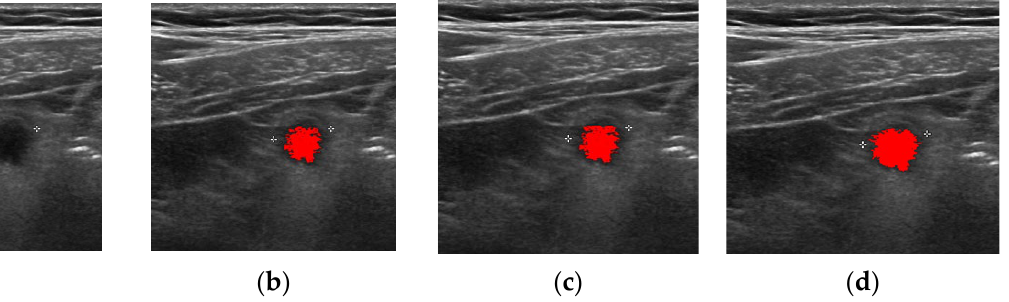
Figure 3. Extraction of inflamed appendix by methods. ( a ) Input, ( b ) FCM, ( c ) DFCM, and ( d ) DORFCM.